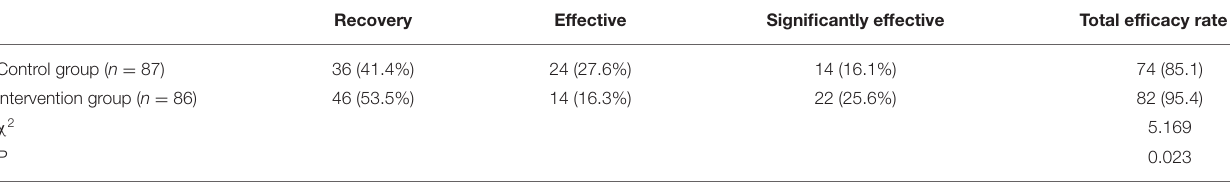
TABLE 2 | Improvement of swallowing function in the two groups.